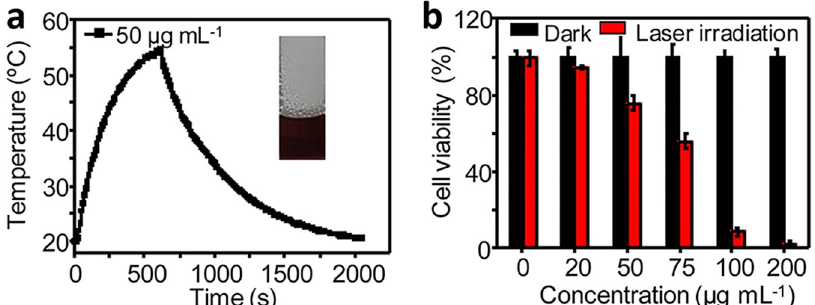
Fig. 6 RTCDs for photodynamic therapy. a Photothermal effects of the RTCD water dispersion (50 μ g mL − 1 ) for 10 min irradiation (black line). The inset is a photograph of the RTCD aqueous dispersion after laser irradiation. b The viability of MCF-7 cells incubated with different concentrations of the RTCDs (0 − 200 μ g mL − 1 ) before (black bar chart) and after (red bar chart) laser irradiation for 10 min. (Fig. 6a, b adapted with permission from ref. 51 , Copyright 2016 American Chemical